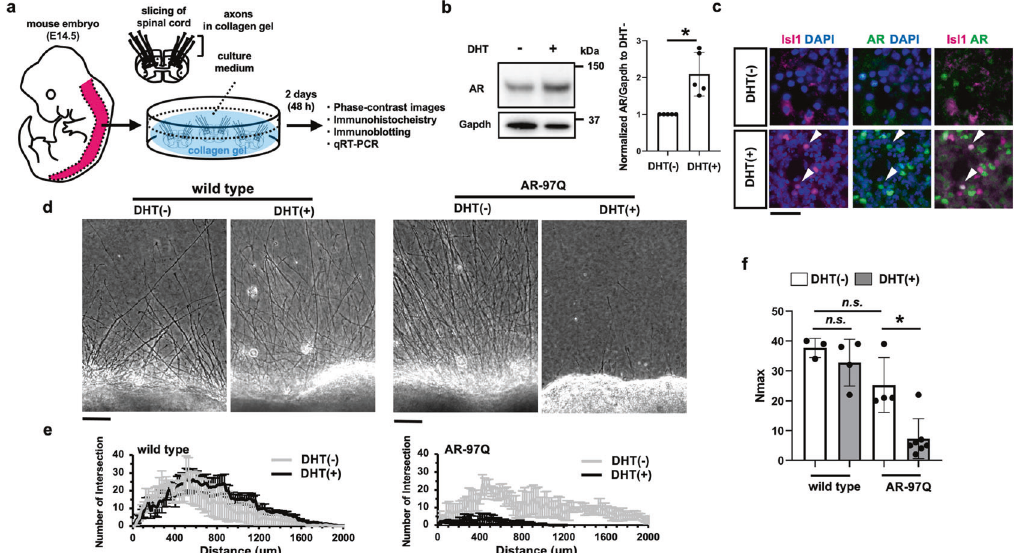
Fig. 4 Androgen-dependent impairment of axonogenesis in the spinal cord slice culture from SBMA mice. a A schematic procedure for the spinal cord slice culture from AR-97Q mouse fetus at the embryonic day 14.5. Cultured spinal cord slices were collected on Day 2 and used for subsequent analyses. Phase-contrast images were acquired, focusing on the anterior side with the axons extended into the collagen gel. b Increased pathogenic AR protein levels. The left and right panels show the immunoblots and quantitative densitometry analyses for human AR protein levels in the spinal cord slice culture from AR-97Q mice, respectively ( n = 5 pairs of slice cultures per group). The data were normalized to the AR protein levels without DHT treatment. Statistically, signi fi cant difference was detected by unpaired two-tailed one- sample t -test (* p < 0.05). c Co-immunostaining for nuclear human AR and Isl1, a motor neuronal marker, under DHT treatment but not without DHT in the spinal cord slice cultures from AR-97Q mice. d Phase-contrast images showing the effects of DHT treatment on the axonogenesis of the spinal cord slice culture from AR-97Q and wild-type male mice. e Quanti fi cation of the axonal distribution using Neurite-J [37]. The number of intersections was shown as a function of the distance from the center of the culture bodies. Mean ± standard error of the mean (s.e.m.) are shown ( n = 3 – 7 samples per group). f Comparisons of the maximal number of axons detected in an image ( N max ) calculated from the plots in e . Mean ± standard deviation (s.d.) are shown. Statistically, signi fi cant difference (* p < 0.01) was detected by Tukey ’ s multiple comparisons test.